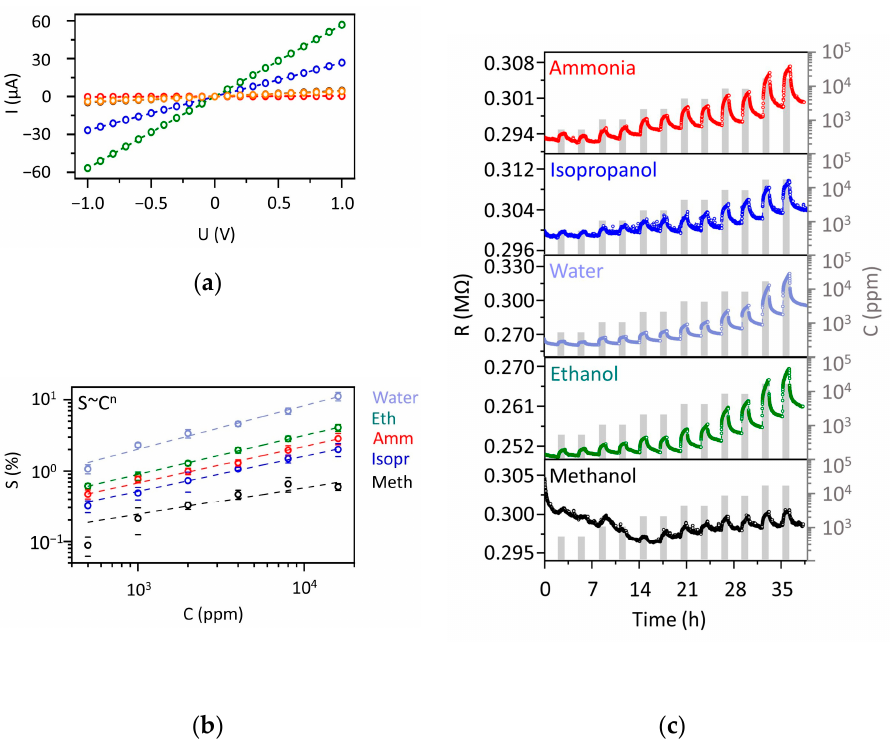
Figure 7. The gas sensing performance of Ti 0.2 V 1.8 C MXene-based chemiresistive sensor under RT conditions: ( a ) I-V curves for five sensor elements; ( b ) the chemiresistive response, S(C) , in dependence on volatile analyte concentration, the points are experimental data, the curves are fitting with S ∼ C n function; ( c ) the typical sensor R(t) transient upon exposing to five volatile analytes in wide range of concentrations, C = 500–16,000 ppm.